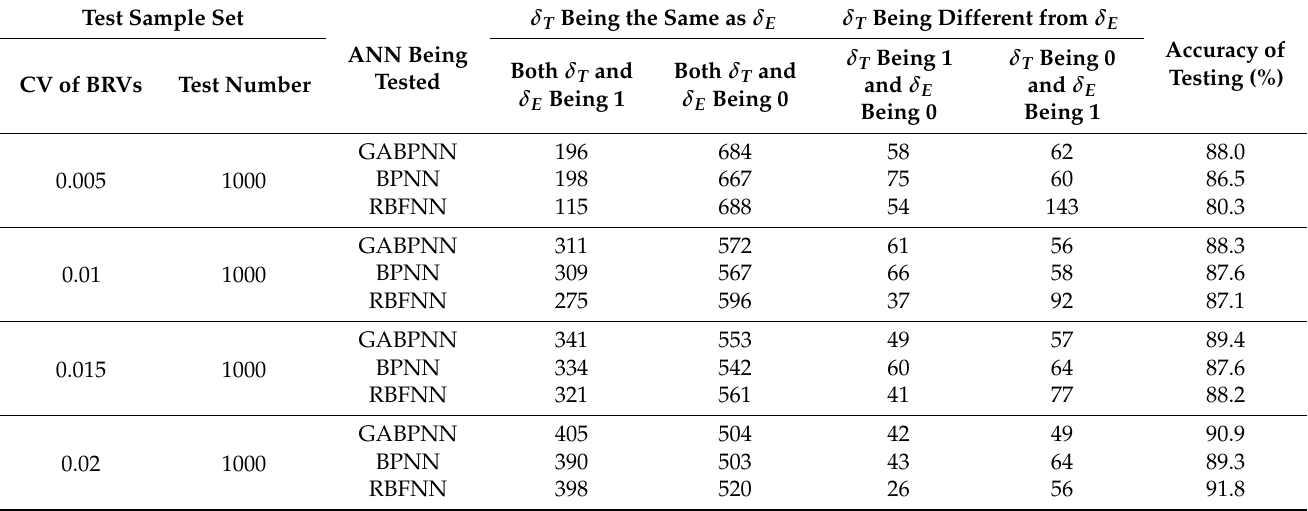
Table 10. The comparison of the test results of the ANNs in the IP study under the shock load condition where v is 1000